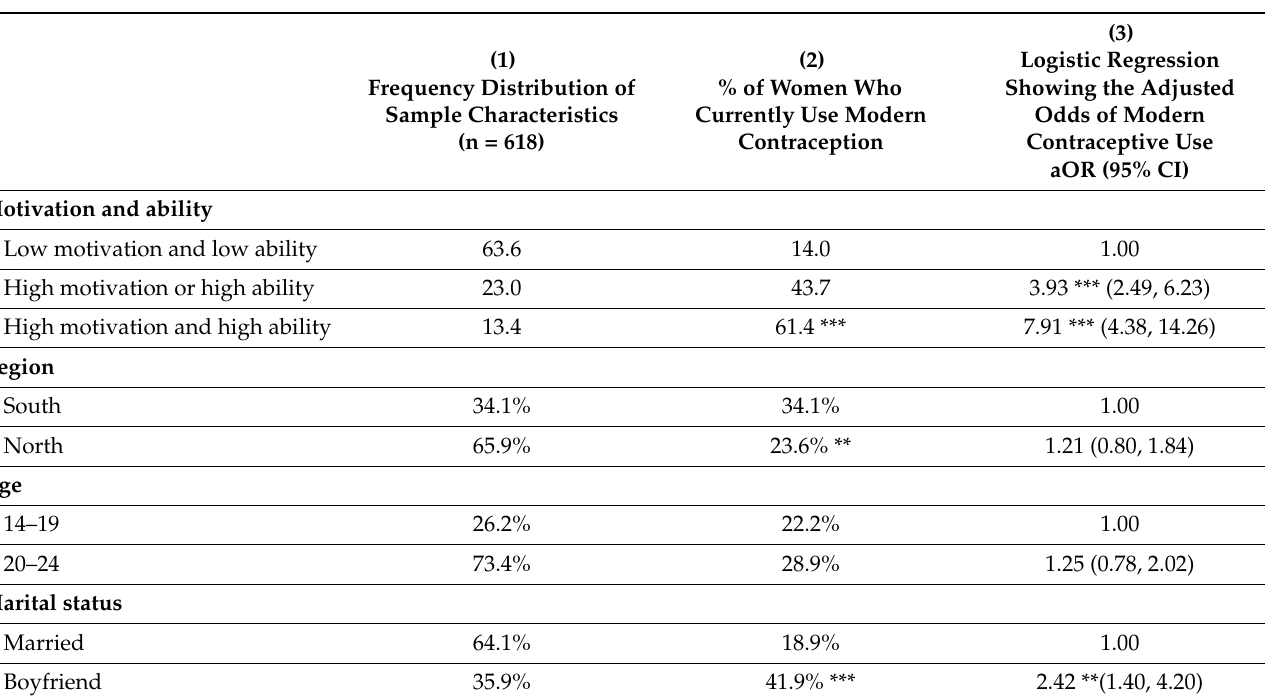
Table 6. Logistic regression showing the adjusted odds of modern contraceptive use among adoles- cent and young women,